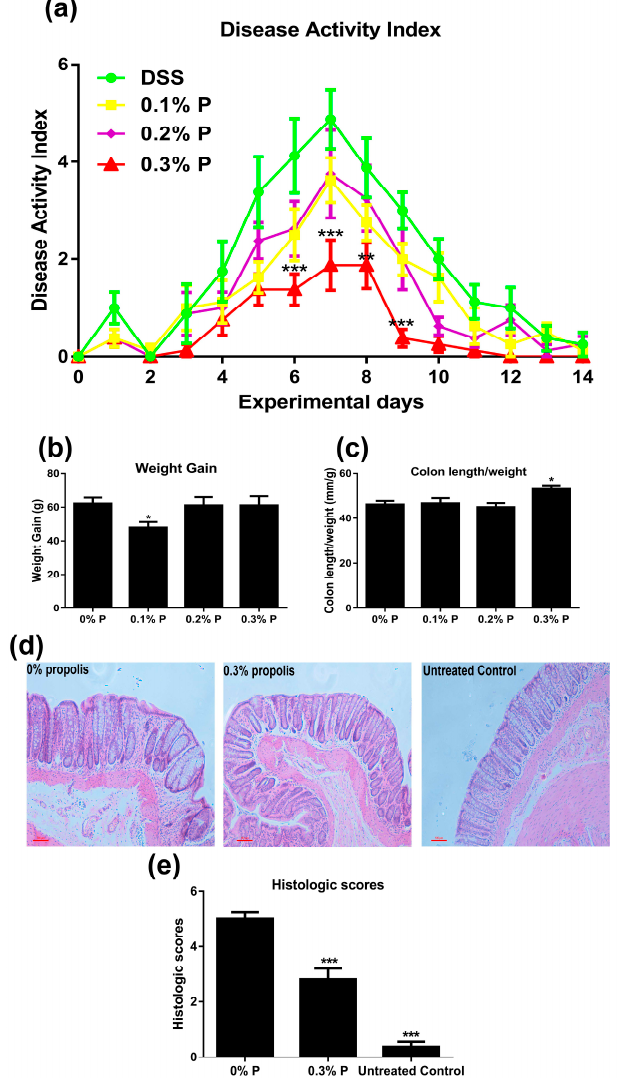
Figure 1. Effects of propolis administration on severity of DSS-induced colitis. Rats were fed with Western diet containing different levels of propolis (0%, 0.1%, 0.2%, and 0.3%) starting for one week before experiment treatment (DSS, MW 36–50 kDa, 3% in the drinking water) started. ( a ) Disease activity index (DAI) over the period of experiment; ( b ) weight gain at the end of the experiment; ( c ) colon length/weight ratio was calculated at the end of the experiment; ( d ) Representative H and E- stained sections from 0% propolis, 0.3% propolis, and the untreated control group; ( e ) The histologic scores of rats (0 for no inflammation, 6 for maximal tissue damage and cell infiltration). The data represent the mean ± SEM of eight rats per group. * p < 0.05, and *** p < 0.001 significant difference versus the 0% propolis group.